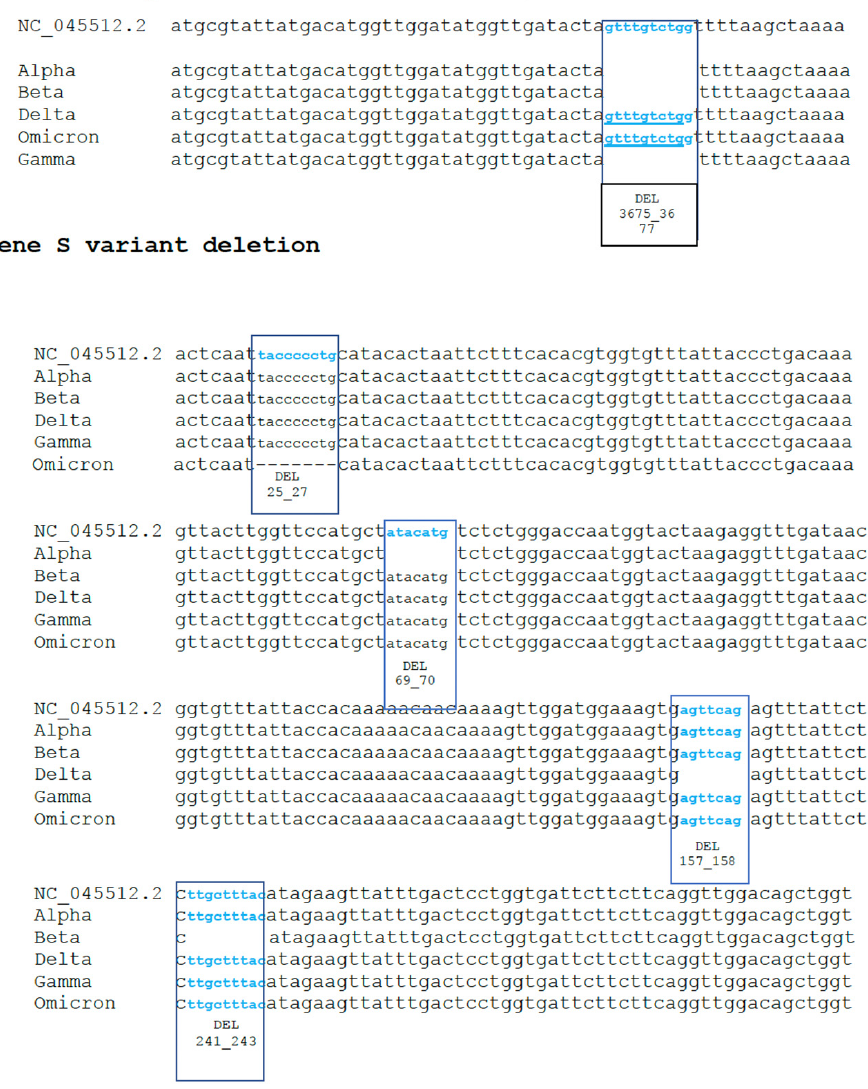
Figure 1. Portion of S gene sequence (of the SARS-CoV-2 genome): Wild type and variant showing the deletions 69–70 and portion of ORF1a gene with deletion 3675/3677.